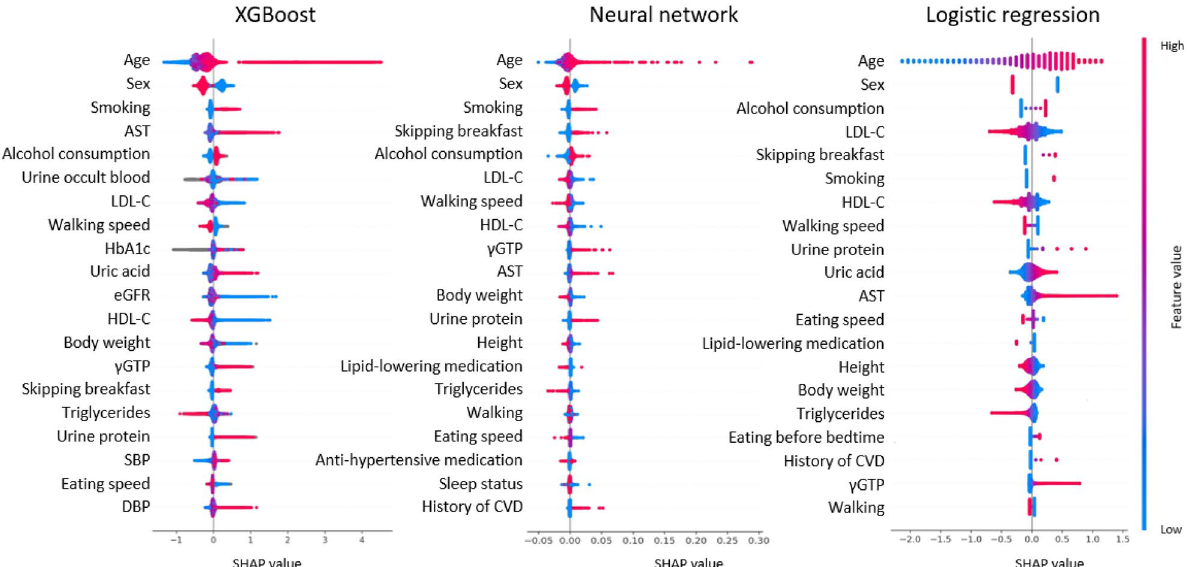
Figure 4. The distribution of SHAP values (impact on mortality) of explanatory variables for predictive models. The effects of the variables on the outcome were plotted for each individual in the test dataset. Cases with high values are shown in red, and those with low values are shown in blue. The variables are ranked in descending order. The horizontal location indicates whether the effect of that value is associated with a higher or lower prediction. AST aspartate aminotransferase, eGFR estimated glomerular filtration rate, LDL-C low-density lipoprotein cholesterol, HDL-C high-density lipoprotein cholesterol, γGTP γ-glutamyl transpeptidase, SBP systolic blood pressure, DBP diastolic blood pressure, CVD cardiovascular